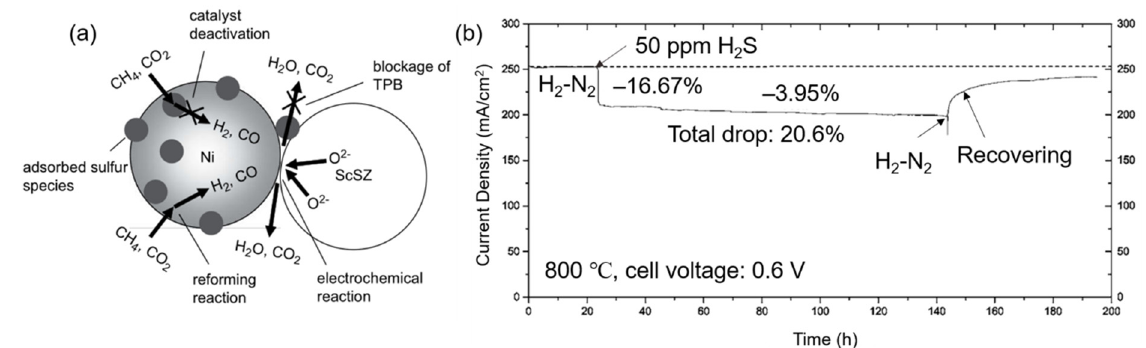
Figure 10. ( a ) Schematic diagram of the degradation mechanism caused by H 2 S poisoning reproduced with permission from Ref. [102]. ( b ) Sulfur poisoning and regeneration or desulphurization processes of Ni-YSZ anodes in a fuel mixture with 50 ppm H 2 S, reproduced with permission from Ref. [101].